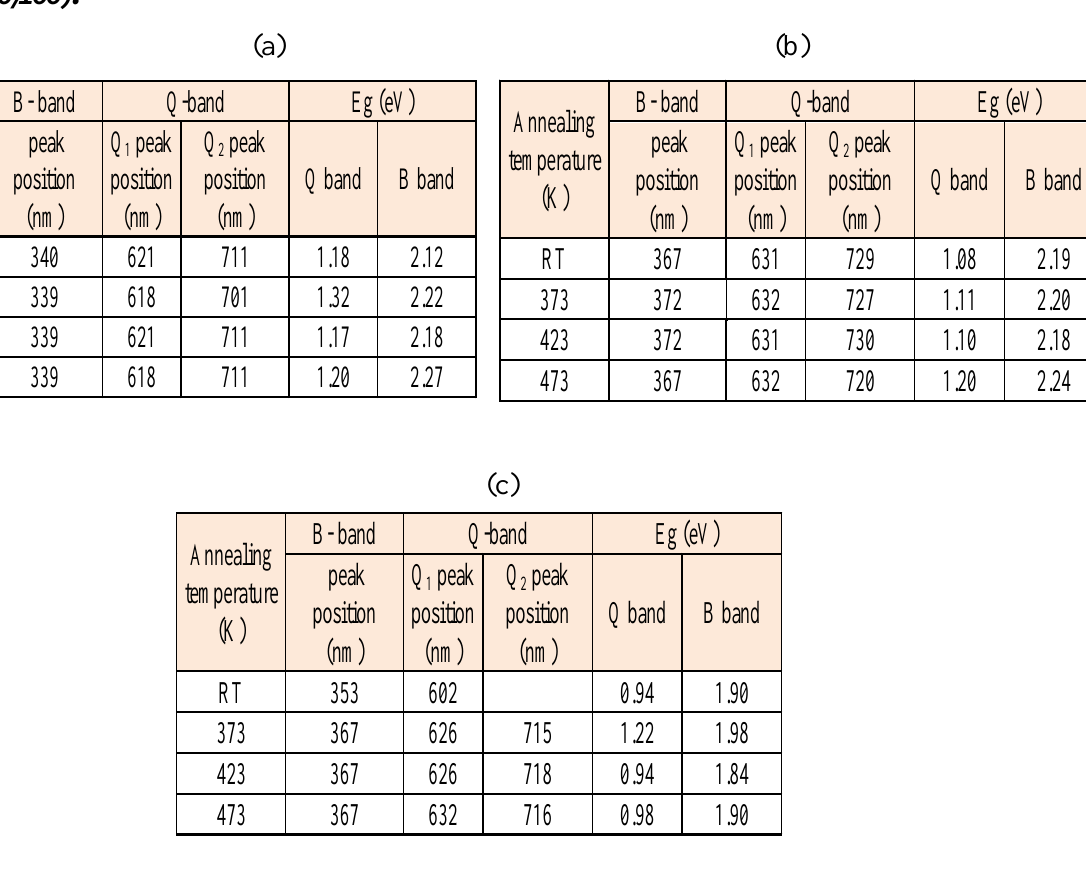
Table 1: Bands position and optical energy gaps of as-deposited and annealed thin films of NiPc/C blends with three different ratios of C 60